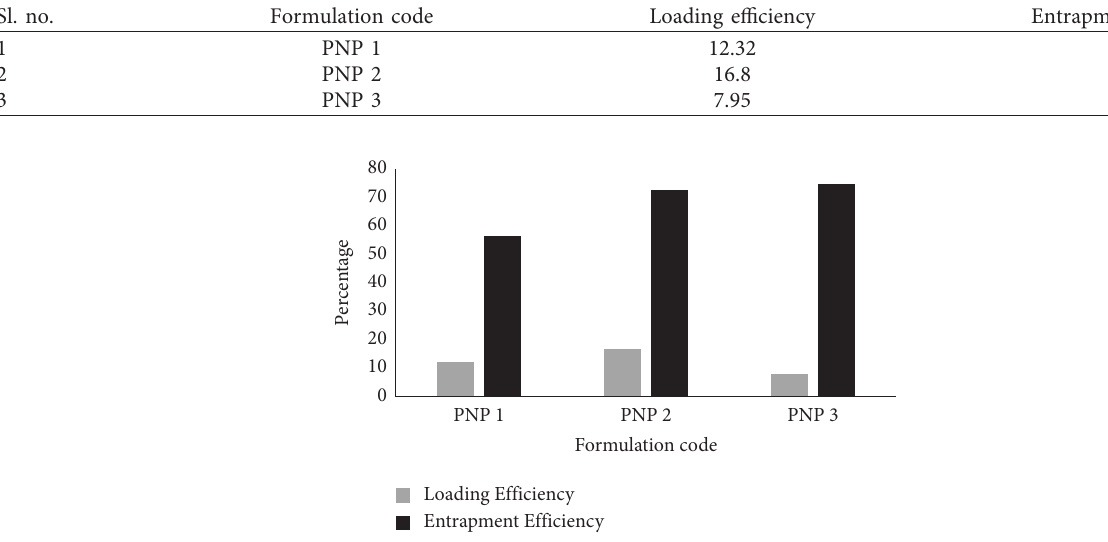
Figure 8: Effect on the loading and entrapment efficiency of the